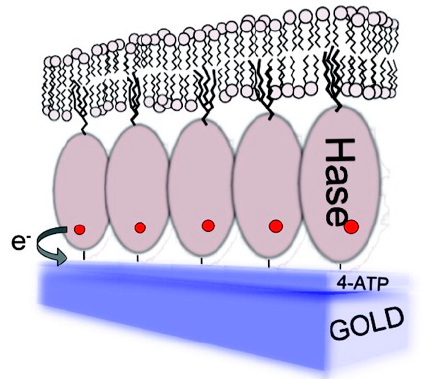
Figure 8. Schematic illustration of [NiFeSe]-hydrogenase covalently inserted into a phospholipidic bilayer. Reproduced with permission from [167]. Copyright 2011, American Chemical Society.